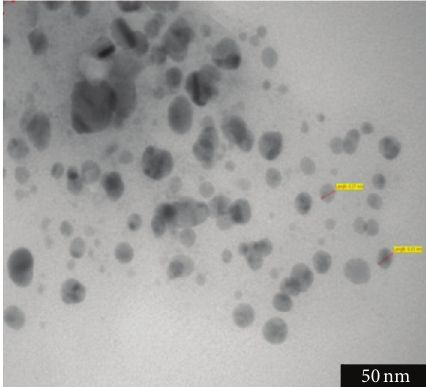
Figure 8: Ag NPs synthesized using Tinospora Cordifolia extract as a reducing agent [50] (reproduced with permission from the